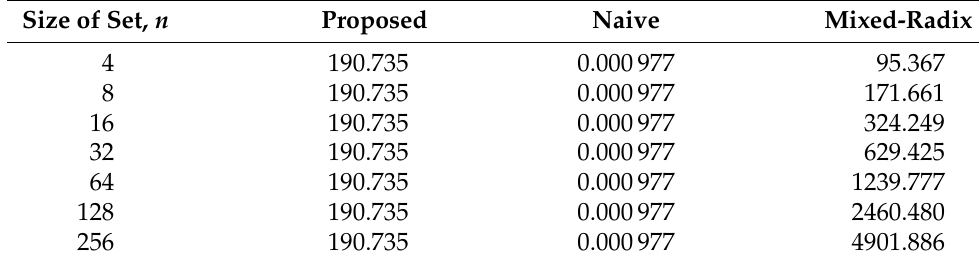
Table 4. Memory consumption (in MB) of the different approaches. Size of Set,